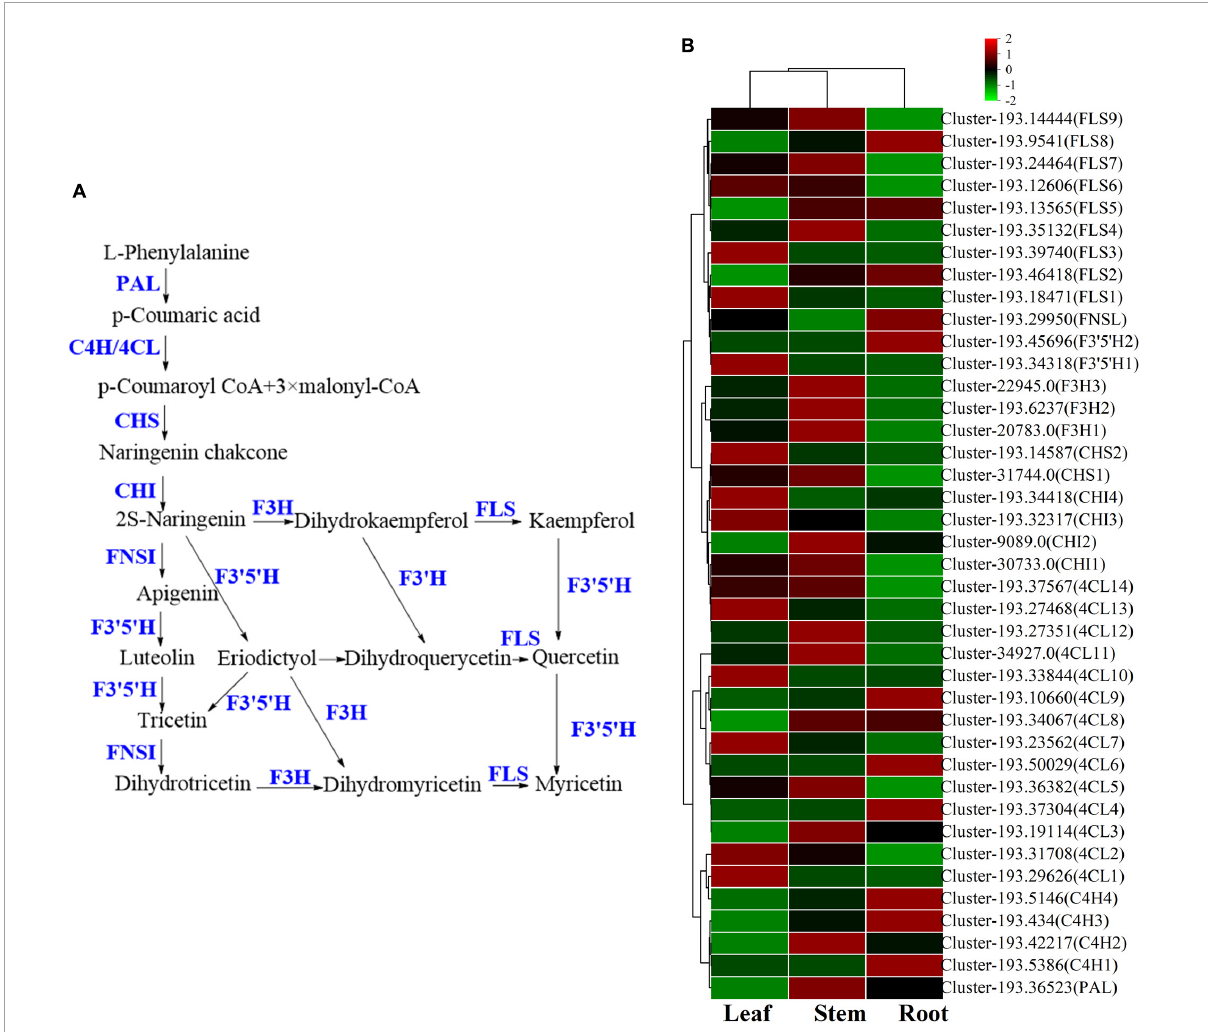
FIGURE10 The flavonoids biosynthesis pathway and the heatmap of corresponding genes in Verbena officinalis . (A) Predicted biosynthetic pathways of flavonoids. Compounds are in black, while enzyme names are in blue. (B) Heatmap of flavonoids pathway